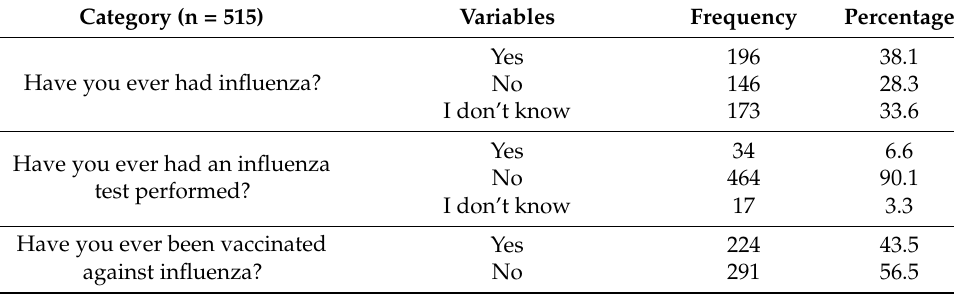
Table 2. History of influenza and influenza vaccination